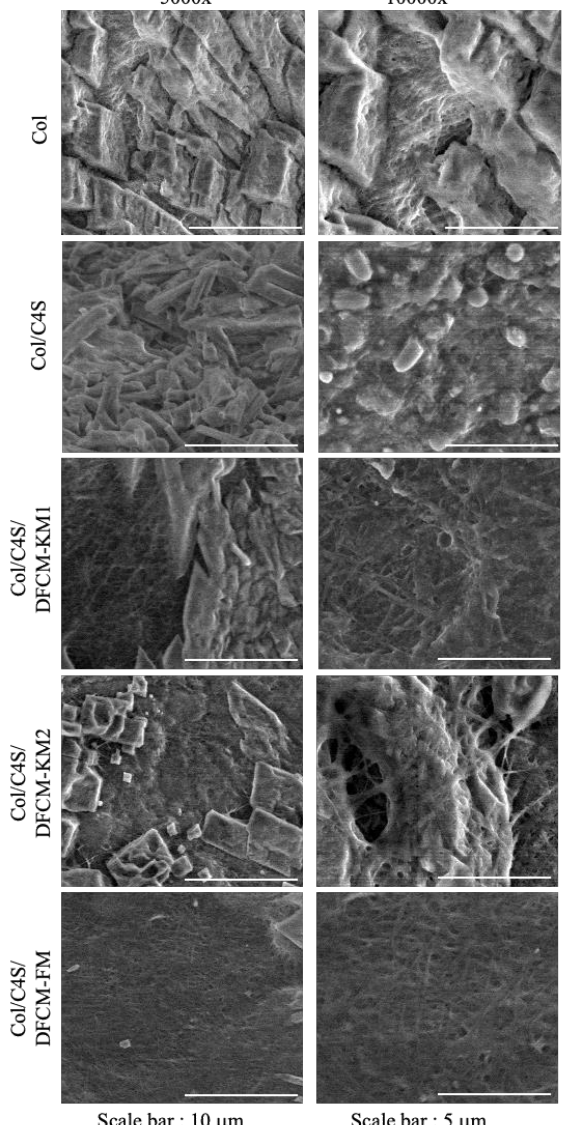
Figure 3. SEM images of Col/C4S/DFCM constructs at 5000 × and 10,000 × magnification. The collagen fibrils were not clearly observed under SEM analysis.